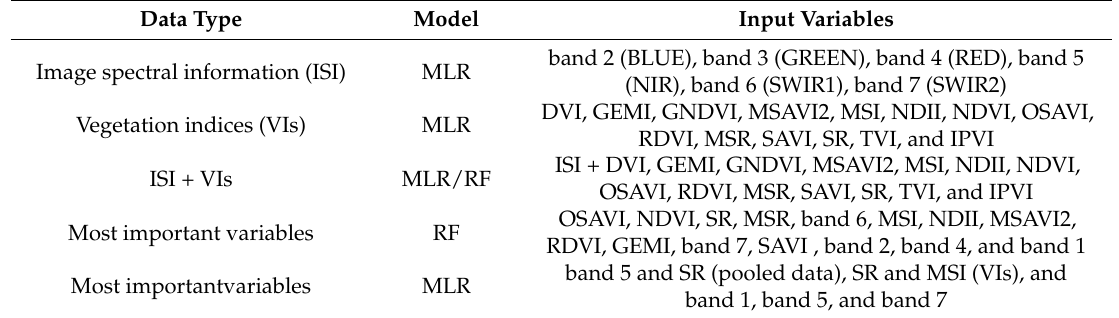
Table 1. Examined variables for the multiple linear regression (MLR) and random forest (RF) models.